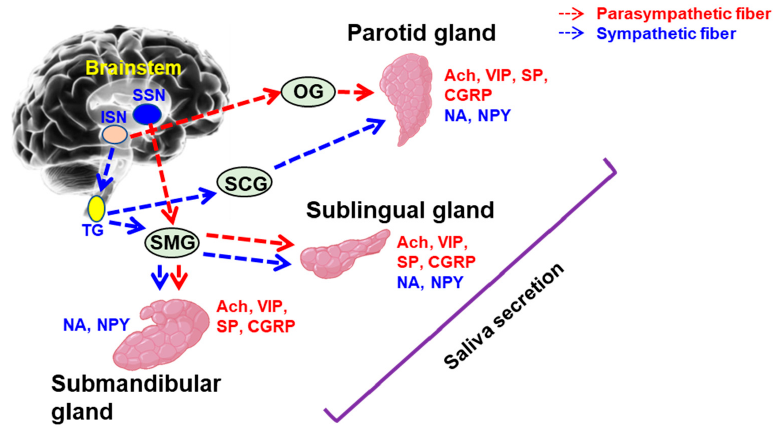
Figure 1. Salivary gland innervation. SSN: superior salivary nucleus; ISN: inferior salivary nucleus; TG: thoracic ganglion; SMG: submandibular ganglion; SCG: superior cervical ganglion; OG: otic ganglion; Ach: acetylcholine; VIP: vasoactive intestinal peptide; SP: substance P; CGRP: calcitonin gene-related peptide; NA: neurokinin A; NPY: neuropeptide Y.